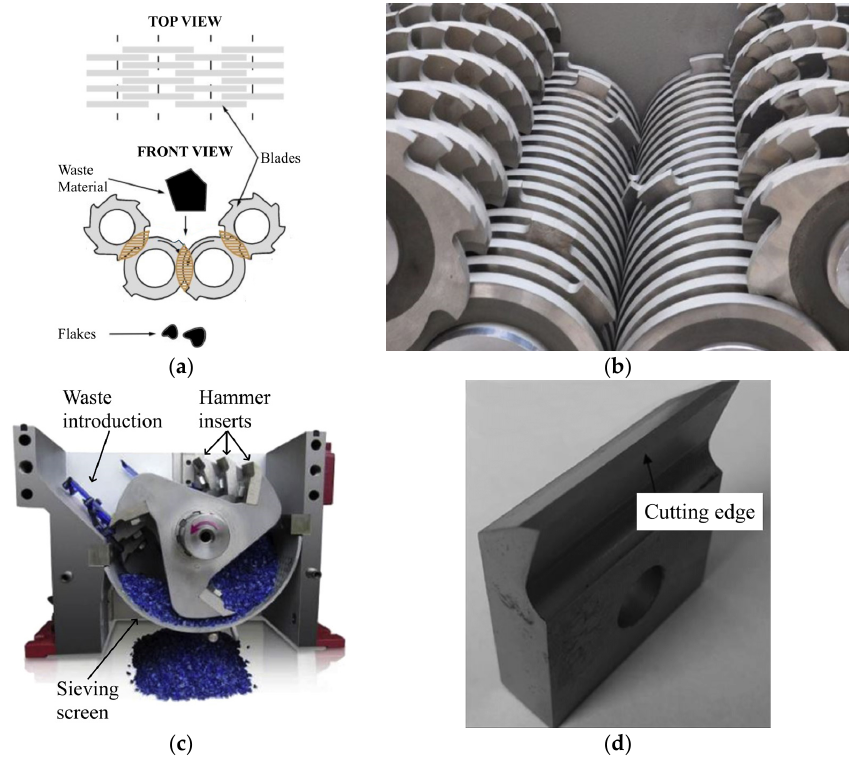
Figure 11. Schematisation of the shredding process ( a ), example of multiple blade shredding ( b ), schematisation of hammer milling process ( c ), example of hammer milling inserts ( d ) [98,100].